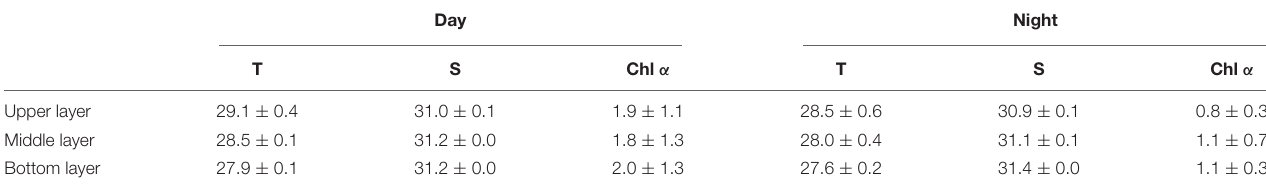
TABLE 1 | Depth-averaged values of seawater temperature (T, ◦ C), Salinity (S, psu), and Chl α concentration ( µ g L − 1 ) at the sampling station in Daya Bay during September 30 to October 2,